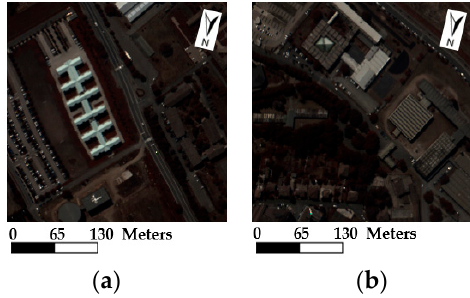
Figure 10. Synthetic RGB images of the test HSIs, taken by ROSIS with bands 31, 21, and 11 as red, green, and blue, respectively: ( a ) Pavia Centre; and ( b ) Pavia University.